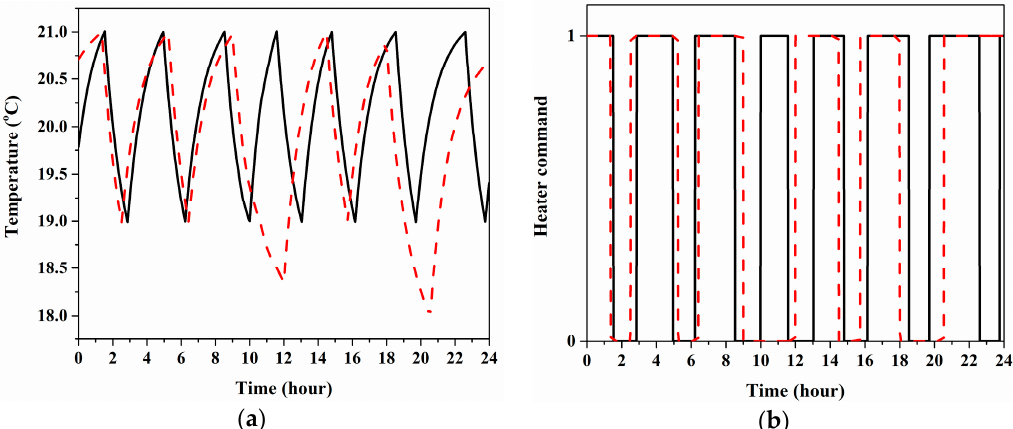
Figure 6. Comparison of indoor temperature and heater signal: ( a ) temperature and ( b ) heater command (—: scenario 1 and - -: scenario 2 B).